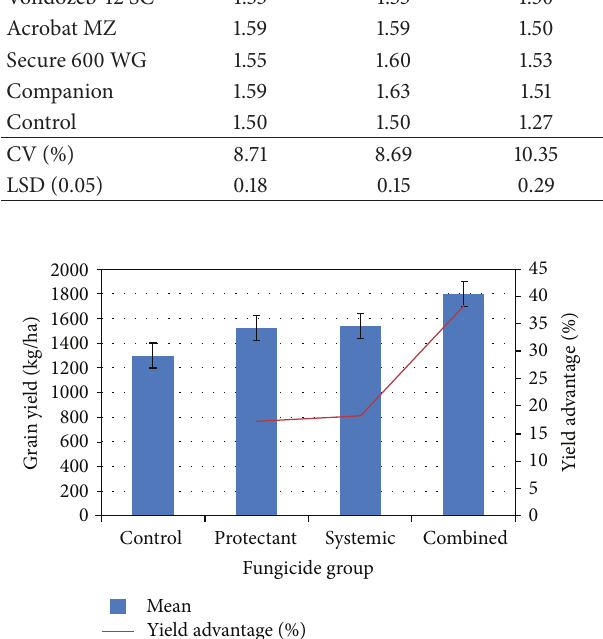
Figure 2: Effect of fungicides on grain yield of BGM susceptible chickpea variety “BARIchhola-1.” Values are means of four replicates over three